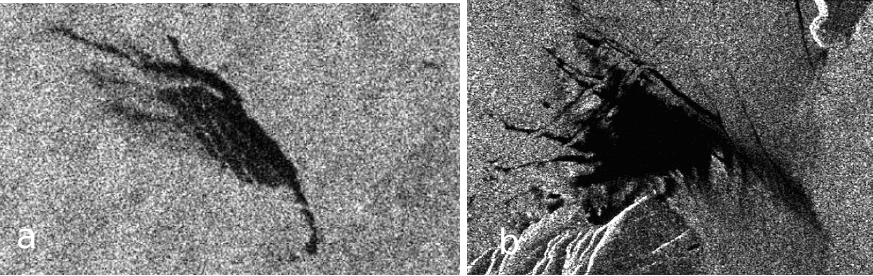
Figure 1. Two examples of dark formations: (a) Verified oil spill on a SAR image taken on 6 September 2005 close to Ancona, Italy. (b) Verified look-alike on a SAR image taken on 25 August 2005 close to Otranto, Italy (Adapted from Stathakis et al.